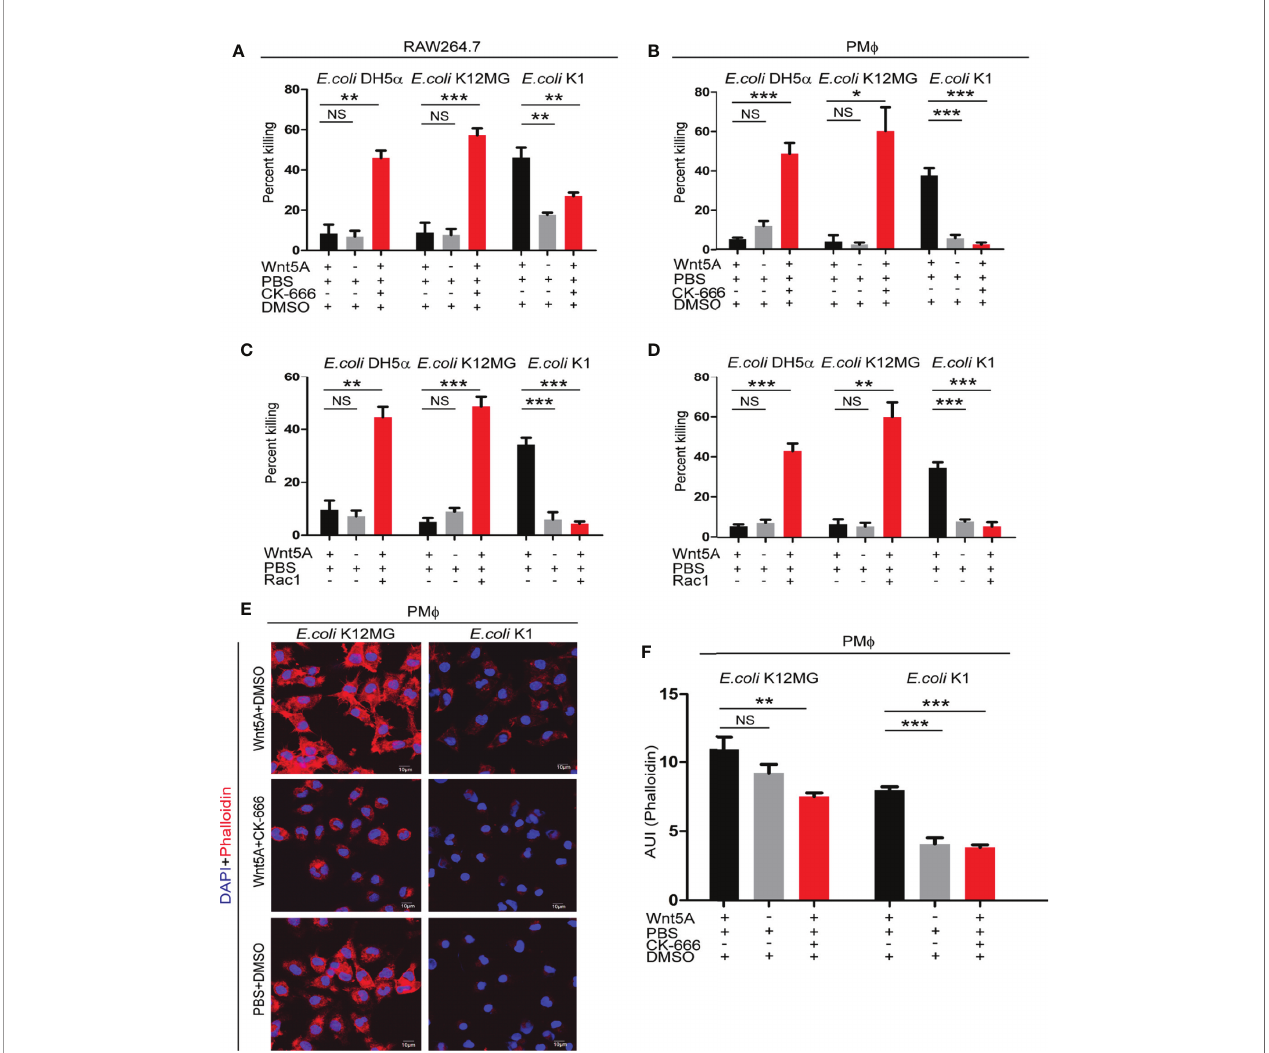
FIGURE 4 | Arp2/3 complex and Rac1 inhibitors modify the Wnt5A induced fate of pathogenic and non-pathogenic bacteria by inducing cytoskeletal actin assembly in infected macrophages. Class I Arp2/3 complex inhibitor (CK-666; 20 µM) (n = 3) and Rac1 inhibitor (Rac1; 15 µM) (n = 3) treatment post infection promoted killing of E. coli K12MG1655 ( E. coli K12MG) and E. coli DH5 a in Wnt5A activated cells but impaired the killing of E. coli K1 in both RAW 264.7and peritoneal macrophages as presented in (A – D) . Arp2/3 complex Class I inhibitor (CK-666; 20 µM) altered Wnt5A induced actin modulation both in case of E. coli K12MG1655 and E. coli K1 as detected by phalloidin staining in peritoneal macrophages and confocal microscopy. F actin organization of Wnt5A+CK-666 added E. coli K12MG set was more than that of the Wnt5A+CK-666 added E. coli K1 set (E, F) (n = 4). DMSO+PBS was used as vehicle control for the experiment. Data represented